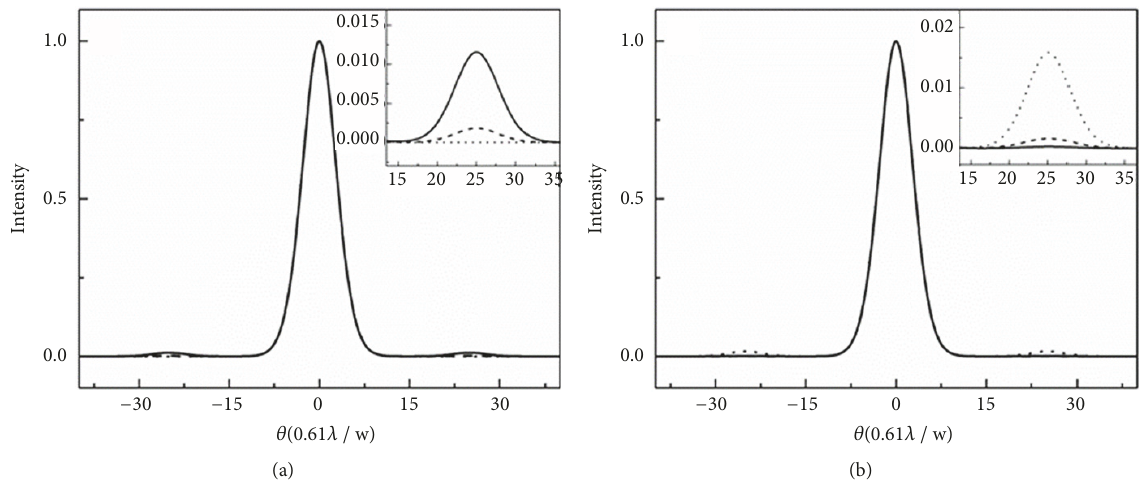
Figure 1: Angular spectrum of output signal beam (a) and idler beam (b) when pump phase is modulated. Dotted line: spatial walk-off effect not considered, a = 0.5. Dashed (solid) line: spatial walk-off effect considered, a = 0.2 (0.5). E 0 = 10 −6 (small-signal condition); crystal length L is 10 mm; L = 0.23 L ; L = 5 L ; n = 4. NL sp